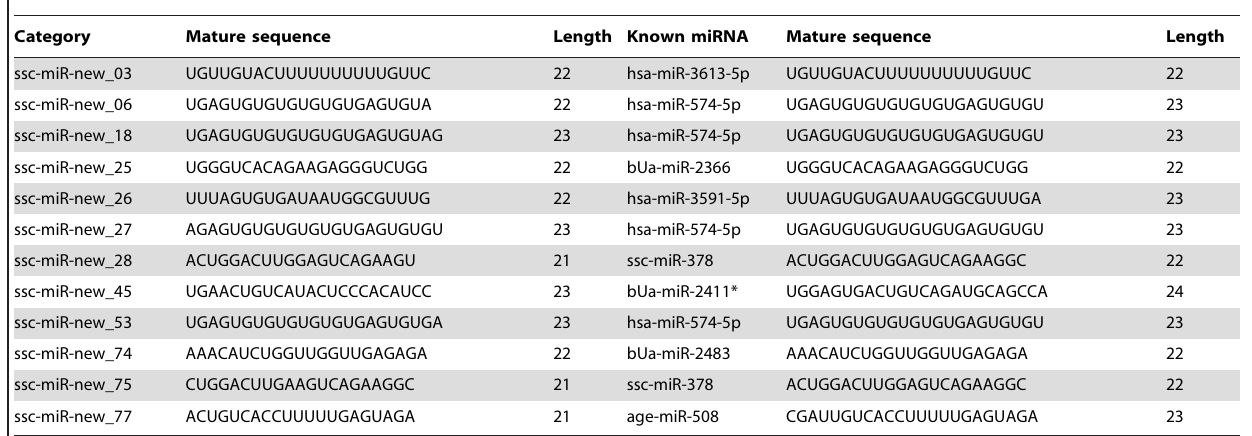
Table 1. Novel miRNAs matched to known